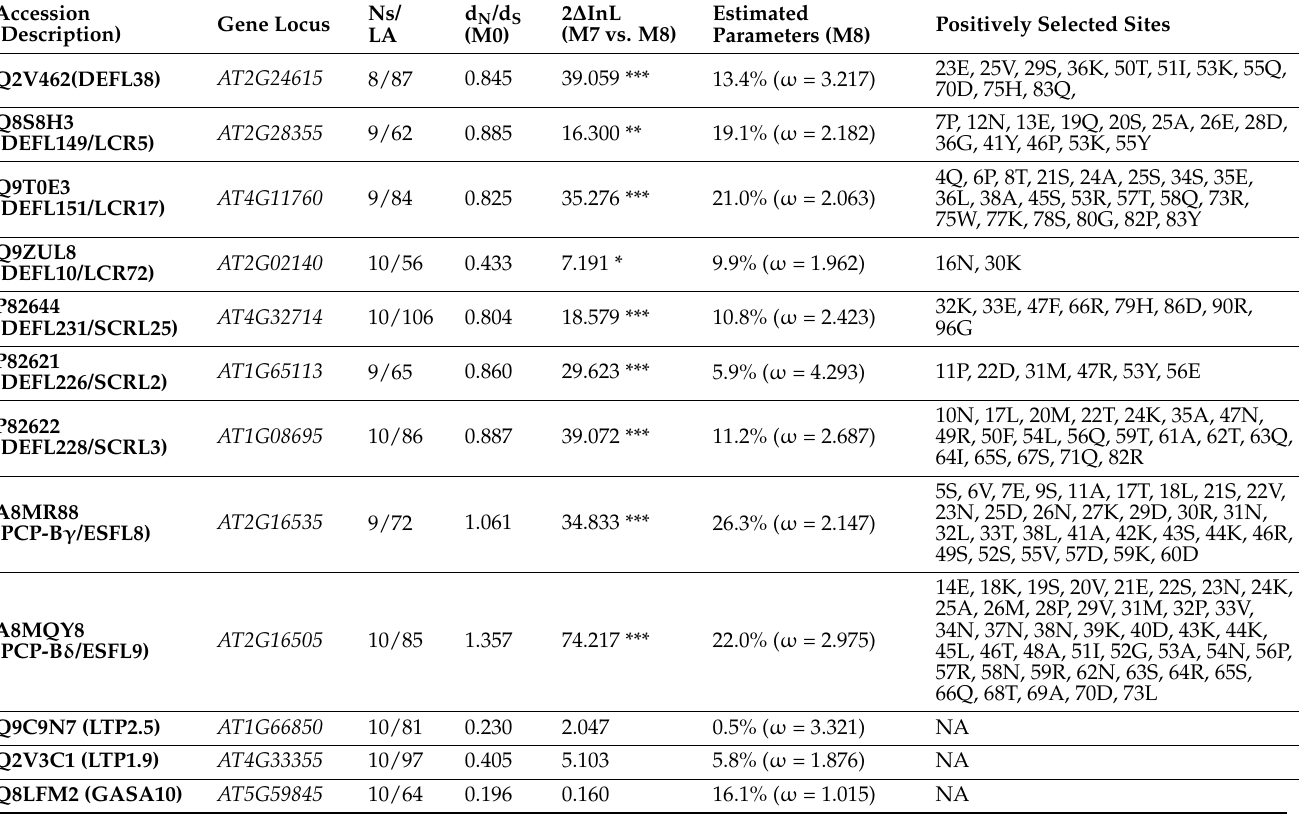
Table 3. Evidence of positive selection on the codon sites of genes expressing cysteine-rich proteins (CRPs) shared among three pollen coat proteomes. M0 results showed the average d N /d S ratio among all sites and lineages. 2 ∆ InL (M7 vs. M8) and its p -value indicate the results of the likelihood ratio test (LRT). * p < 0.05, ** p < 0.001, *** p < 0.0001. Estimated parameters (M8) show the proportion of amino acid predicted to be under adaptive evolution and corresponding d N /d S ratio from model M8. Positive selected sites are amino acids under positive selection with Bayesian posterior p > 0.99 based on model M8 using the Bayes empirical Bayes (BEB) method. NA indicates not applicable, because there was no significant difference between the positive selection model and the neutral model. DEFL, (putative) defensin-like protein; LCR, low-molecular-weight cysteine-rich protein; ESFL, embryo surrounding factor 1-like protein; SCR(L), S -locus cysteine-rich (-like) protein; PCP-B, pollen coat protein B; nsLTP, non-specific lipid-transfer protein; GASA, gibberellic acid-stimulated Arabidopsis. Ns, number of sequences in the analysis. LA, numbers of codons in the